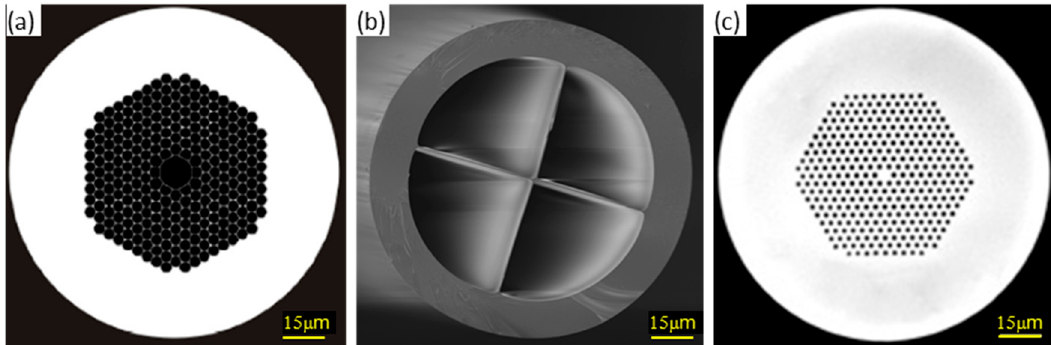
Figure 14. SEM images for ( a ) a Hollow Core fibre, ( b ) a Suspended Core fibre and ( c ) a Photonic Crystal one. Image ( a ) is reprinted from [55] with permission from Elsevier.